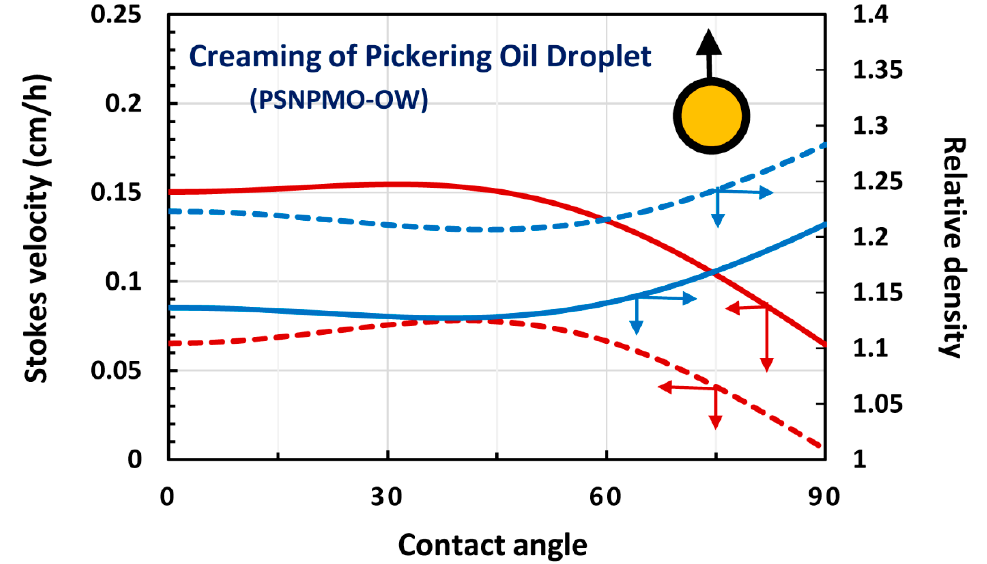
Figure 14. Variations of Stokes rise velocity and relative density of a single Pickering oil droplet with contact angle (PSNPMO-OW Pickering emulsion). The solid curves represent square packing and the dashed curves represent hexagonal packing of nanoparticles at the oil-water interface.